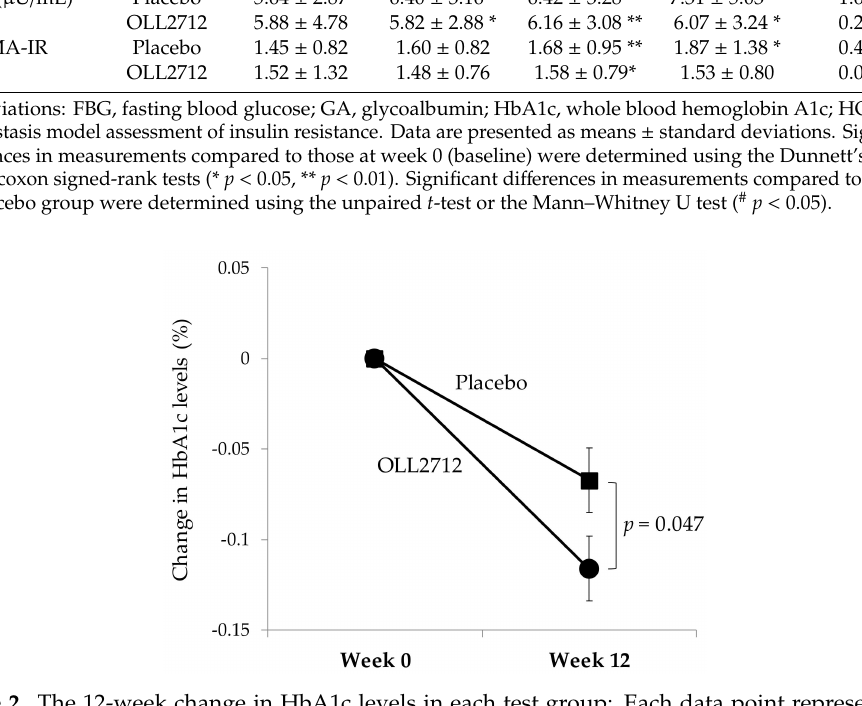
Figure 2. The 12-week change in HbA1c levels in each test group: Each data point represents the mean value ( n = 64 and n = 62 in the placebo and OLL2712 groups, respectively). Error bars indicate standard